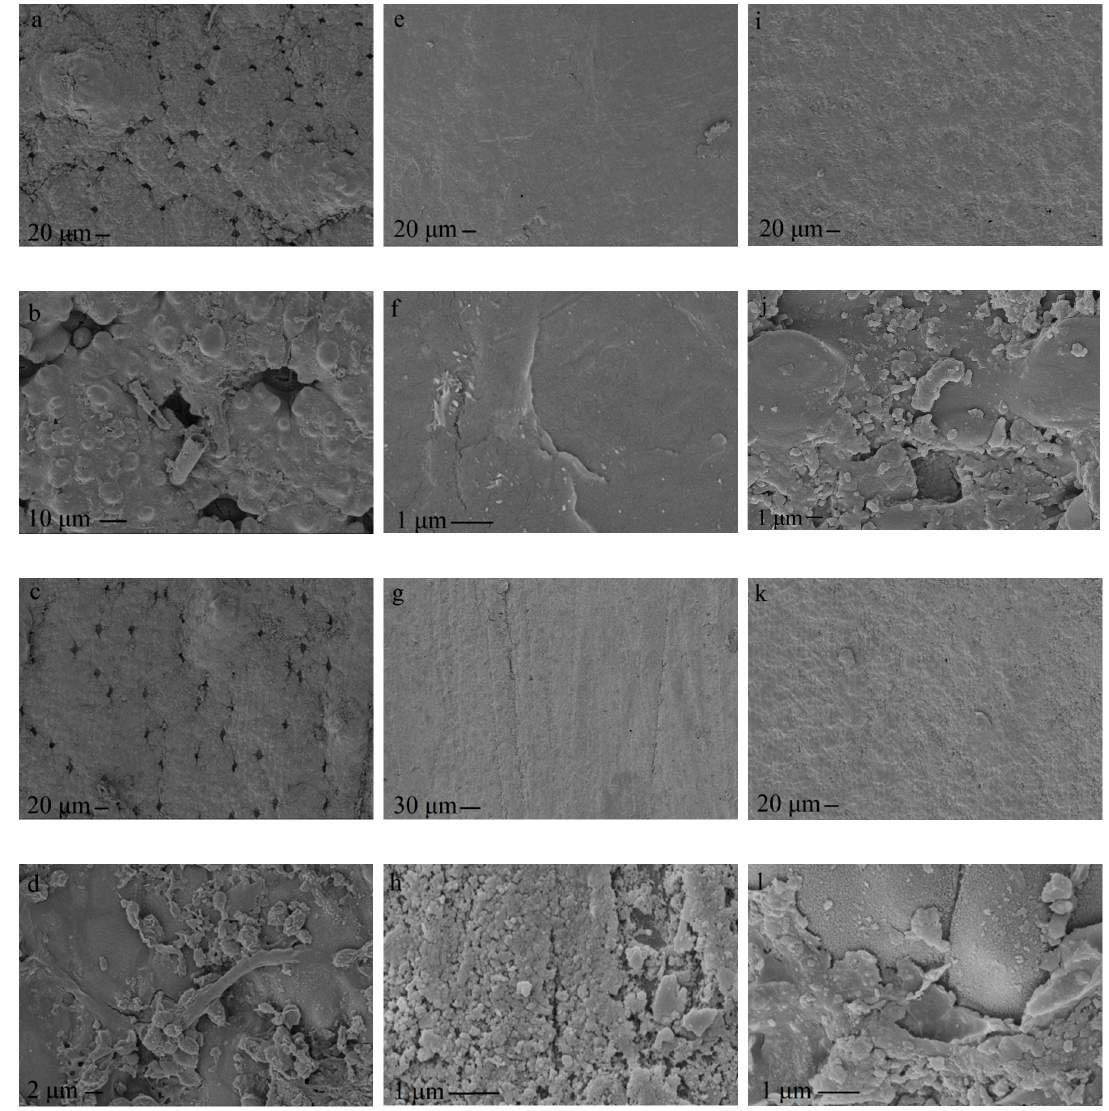
Figure 4. Scanning electron microscopy images of green bamboo surfaces of stem 1 untreated ( a , b ) & treated ( c , d ), stem 2 untreated ( e , f ) & treated ( g , h ), stem 3 untreated ( i , j ) & treated ( k , l ) by plasma